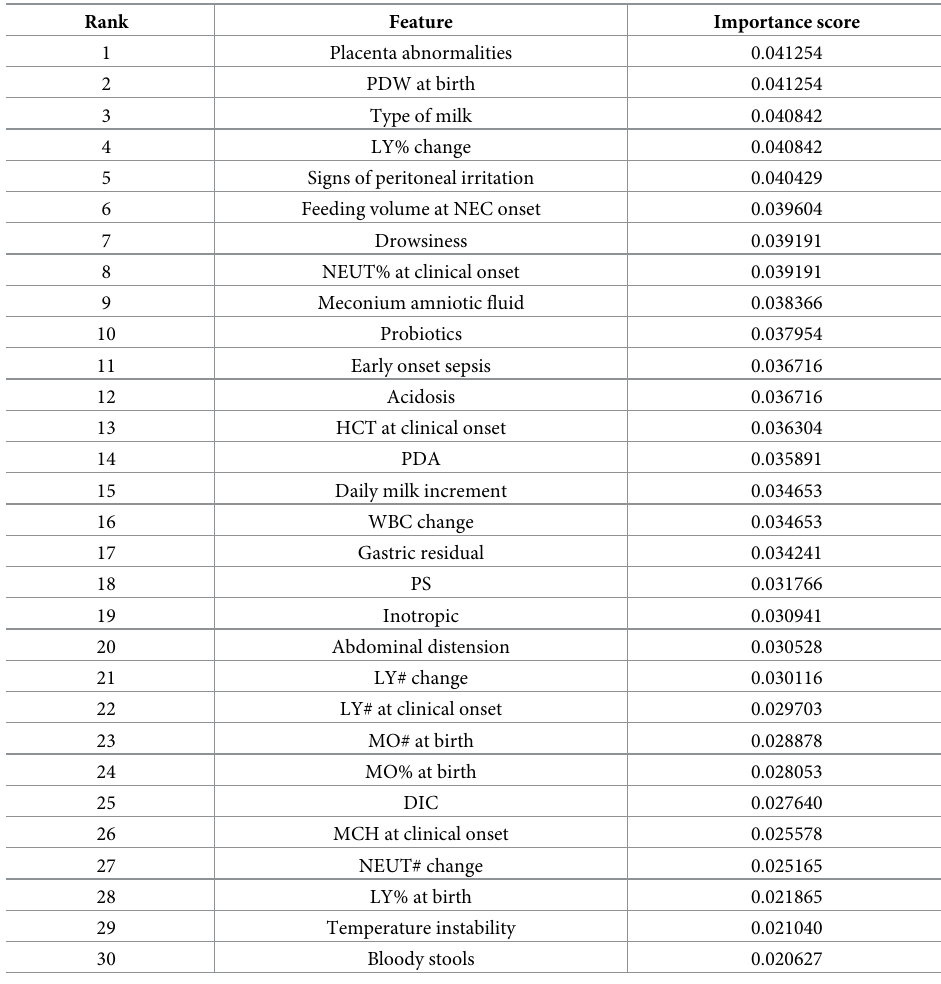
Table 5. Feature importance ranking of dataset